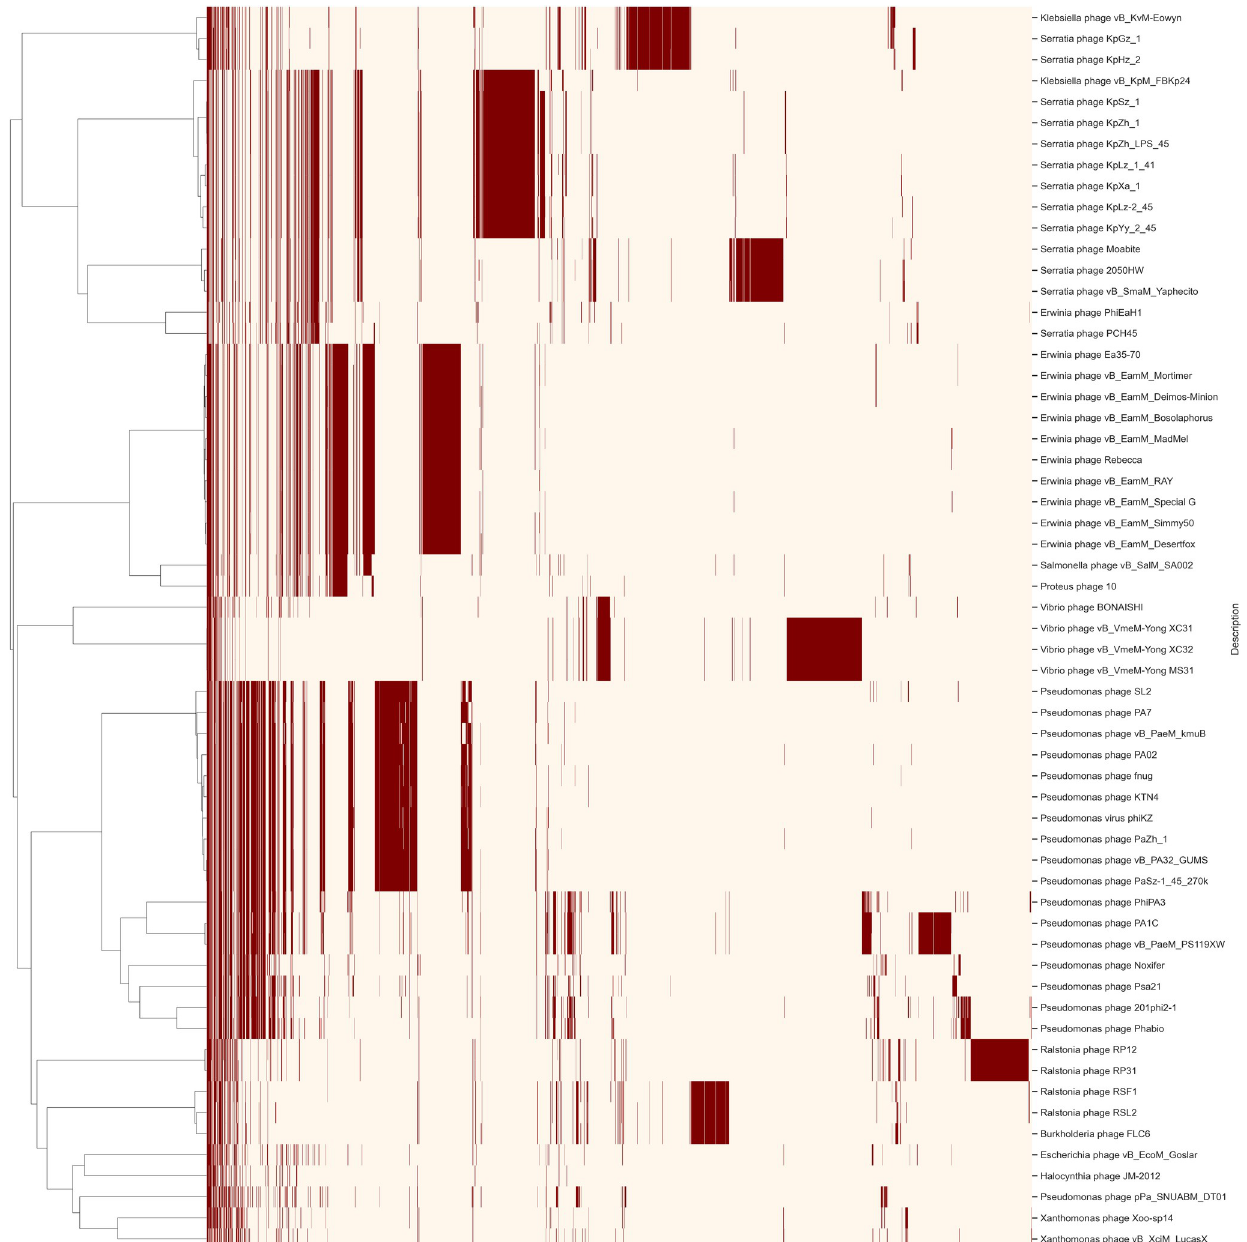
Fig 4. Heatmap analysis of the protein clustering for LucasX and the 58 closest phages performed by vContact2. The presence/absence matrix was generated in python. The red color indicates presence while white represent absence of a protein cluster. https://doi.org/10.1371/journal.pone.0266891.g004 [41], our attempts with this kind of sample were not successful. We also tried to isolate phages by mixing the soil samples with NB medium and filtering the samples before inoculating them with Xac 306, but this approach was also unproductive. LucasX was finally isolated by mixing the soil sample (from a citrus grove afflicted with citrus canker) with NB medium and inocu- lating Xac 306 directly in the suspension, with no prior filtration, as described by Yoshikawa et al. (2018) [20]. Additionally, the same procedure was unsuccessful when LB medium was